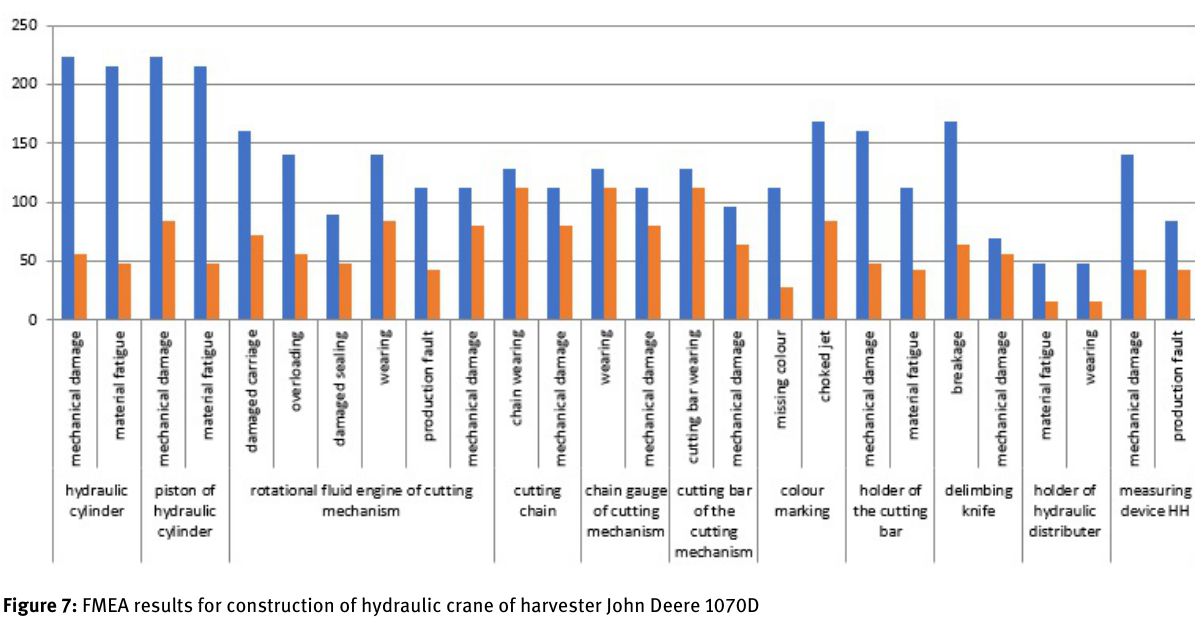
Figure 7: FMEA results for construction of hydraulic crane of harvester John Deere 1070D